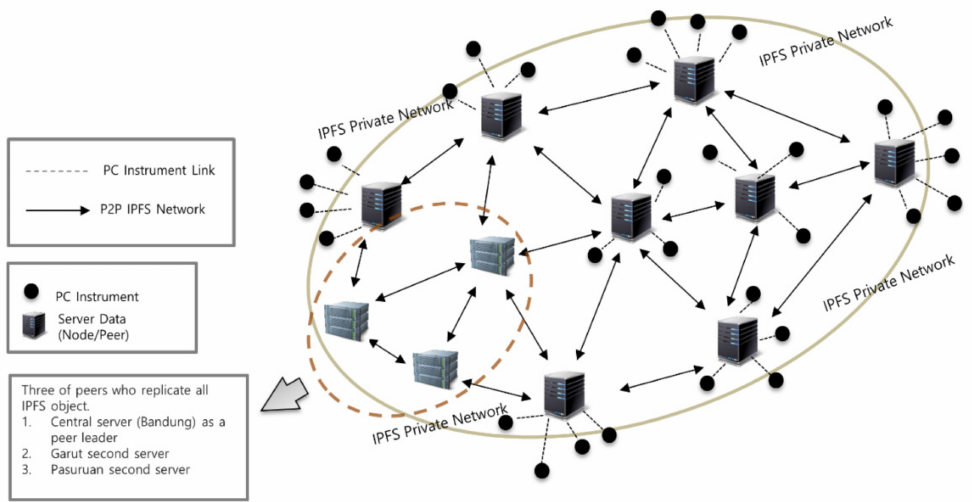
Figure 5. Network